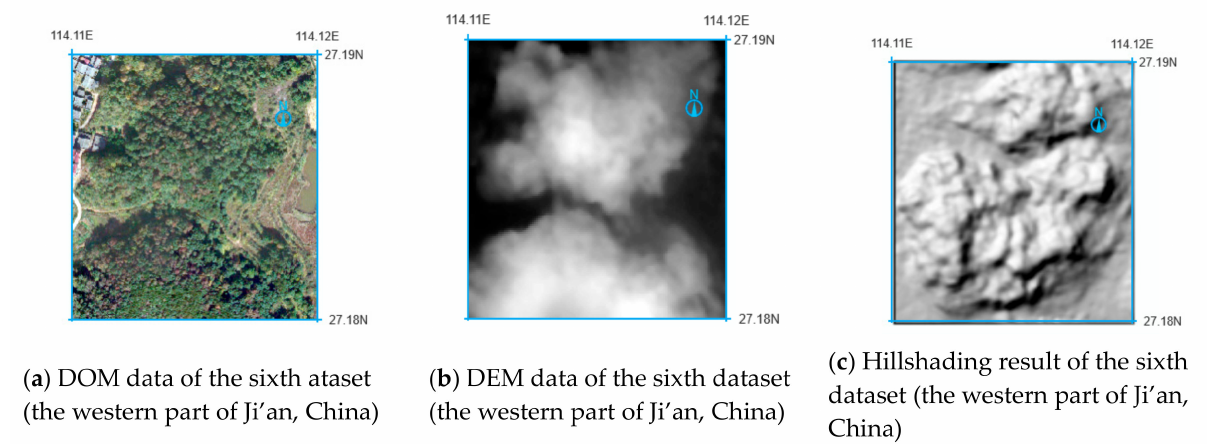
Figure 28. The experimental sixth dataset:( a ) DOM data of the sixth dataset (western part of Ji’an, China); ( b ) DEM data of the sixth dataset (western part of Ji’an, China); ( c ) Hillshading result of the sixth dataset (western part of Ji’an,